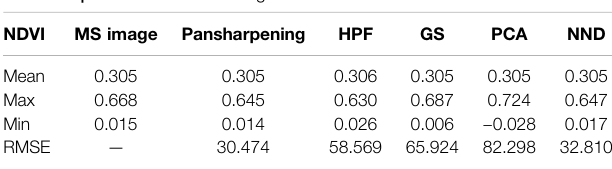
TABLE 2 | NDVI of the fused